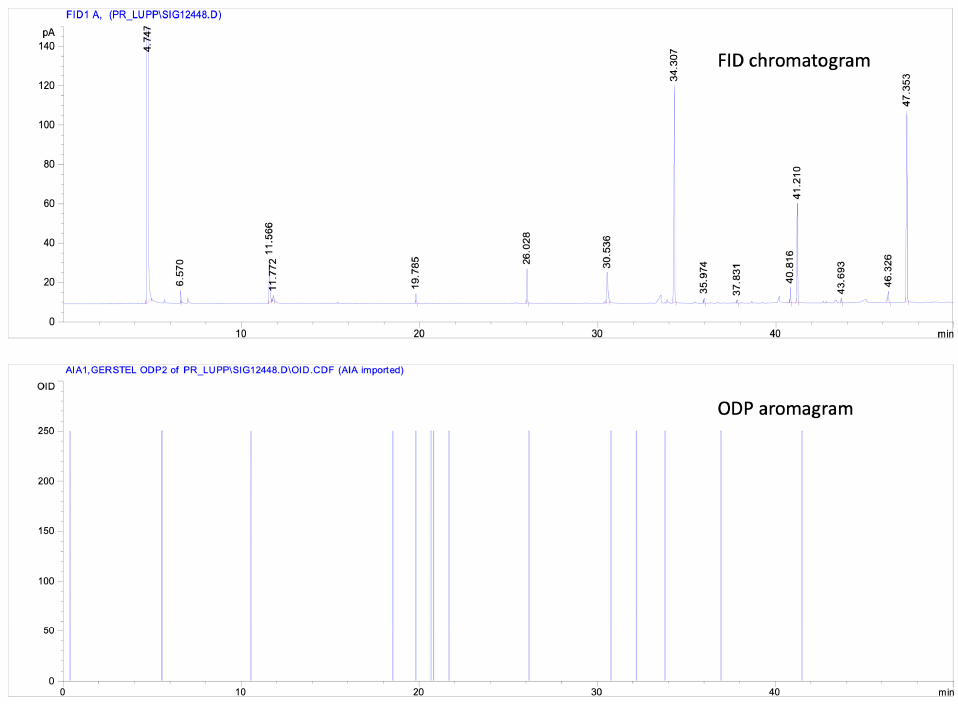
Figure 1. A representative aromagram from Gas chromatography-olfactometry (GC-O) analysis of hop samples analyzed. Table 2. GC-O analysis of hop samples: odour descriptors, average peak areas, and maximum odour intensities.